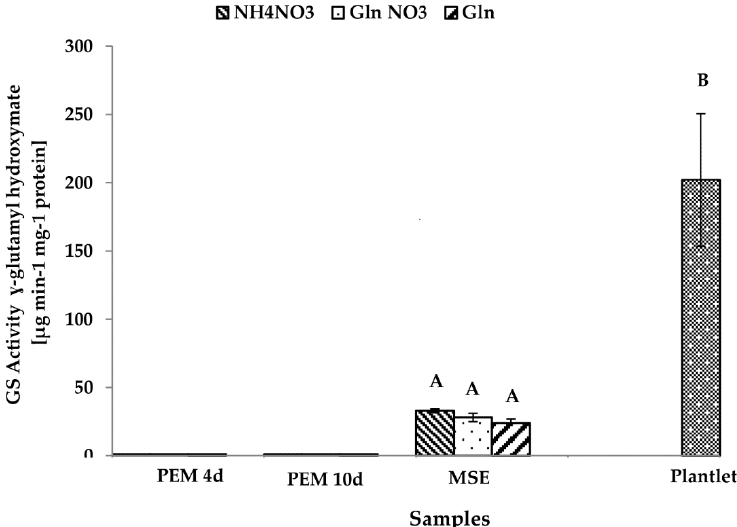
Figure 6. GS activity of PEMs after 4 days (PEM 4d) and after 10 days (PEM 10d) on standard or experimental media and of mature somatic embryos (MSE) generated on NH 4 + NO 3 medium, Gln + NO 3 medium and Gln medium in comparison with two-month-old somatic embryo-derived plantlets. Bars indicate standard errors. Different letters above the columns indicate significant differences based on the Tukey-Kramer HSD test, p ≤ 0.05.